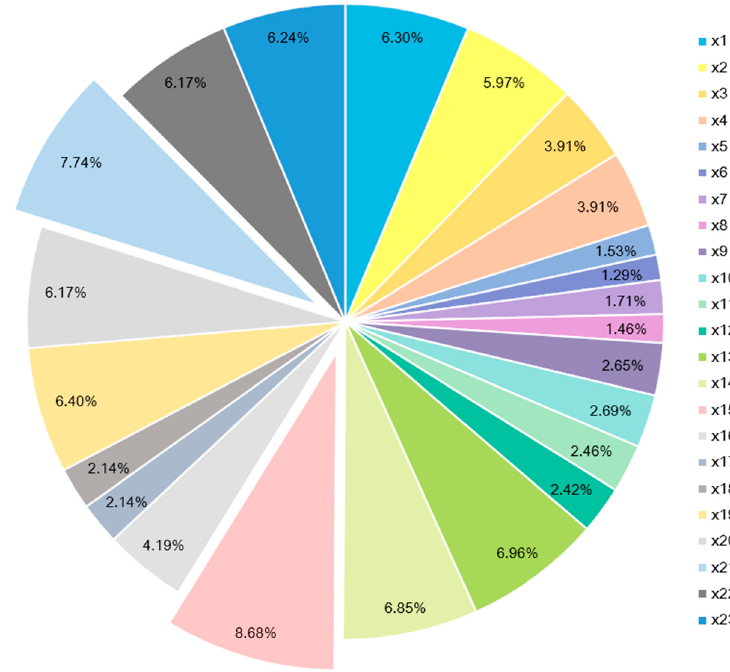
Figure 3. The subjective weight ratio of the criteria.